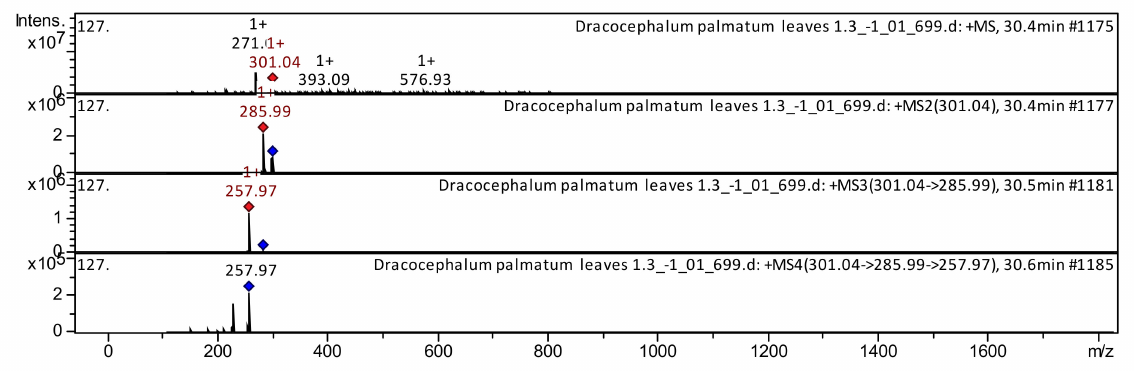
Figure 3. CID spectrum of diosmetin from extracts of D. palmatum , m / z